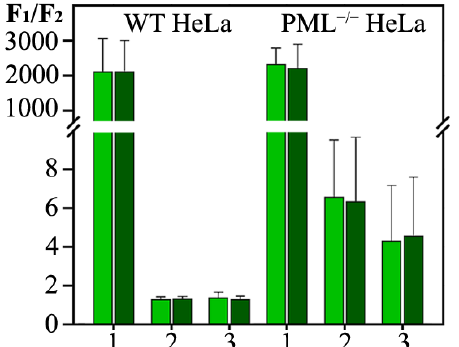
Figure 4. Relative contents of the isoform PML-V, PML-V-CT and PML-V-CT/K490R in bodies formed by these proteins and nucleoplasm in the WT HeLa (on the left), and in the PML − / − HeLa (on the right) are presented by bars 1, 2, and 3, respectively. Light green bars correspond to the normal conditions and that dark green bar correspond to the H 2 O 2 -treated cells. The concentration of exogenously expressed forms of PML was estimated by the ratio of the average fluorescence intensity observed in the bodies to the average fluorescence intensity in a region of the same size in the nucleoplasm. Bars and error bars represent means and s.d. ( n = 3).